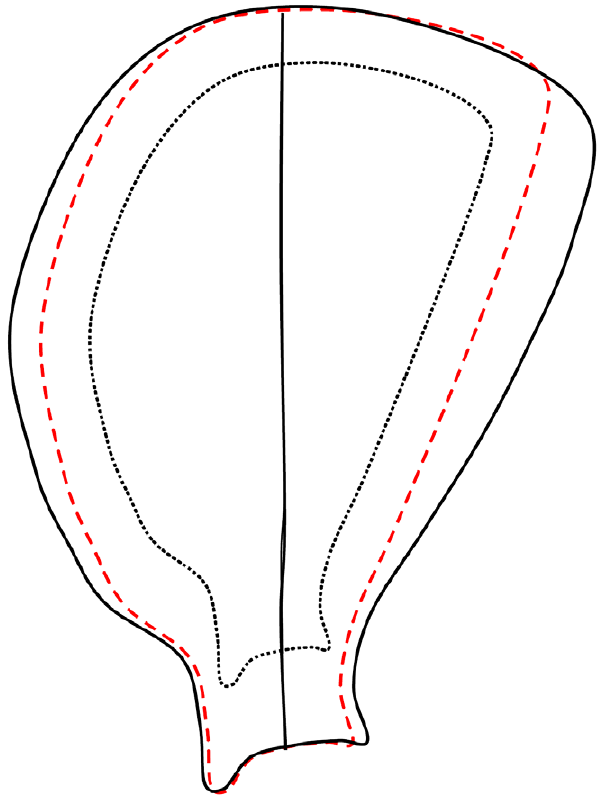
Figure 4. Sketches of scapular fossa when changing size uniformly and accordingly as the first MV of the ‘with size’ SSM. The original fossa is in dashed black; the fossa by changing size uniformly is dashed red, and the fossa by changing size accordingly as the first MV of the ‘with size’ SSM is in solid black. doi:10.1371/journal.pone.0034619.g004 PLoS ONE |